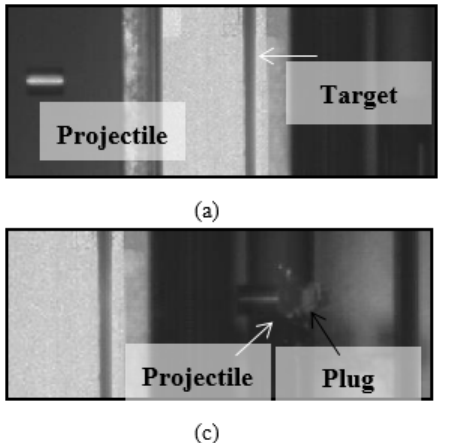
Figure 10. Target mesh used in the numerical simulations.